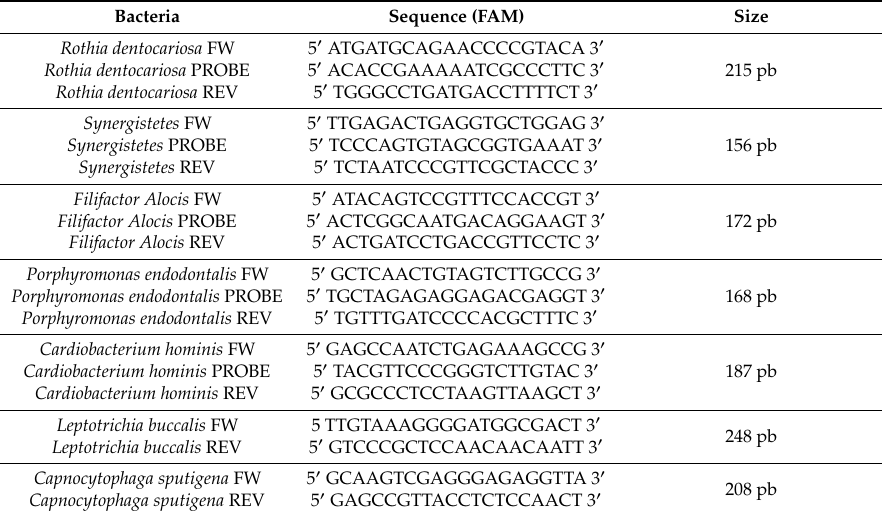
Table 4. Bacteria biomarkers, specific from this invention (patent no.